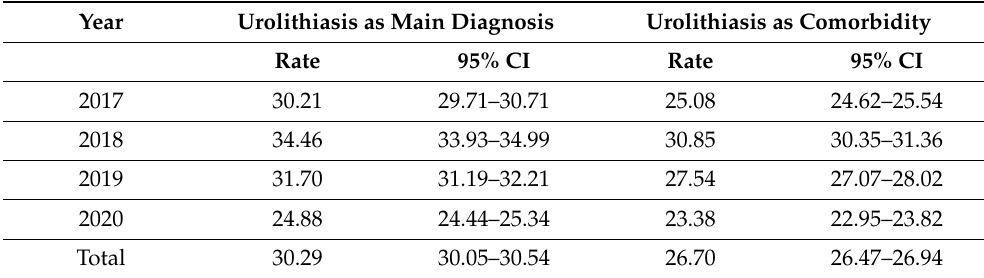
Table 3. Annual hospitalization rate in Spain for kidney stones as the main diagnosis or comorbidity. Annual hospitalization rates per 100,000 inhabitants.